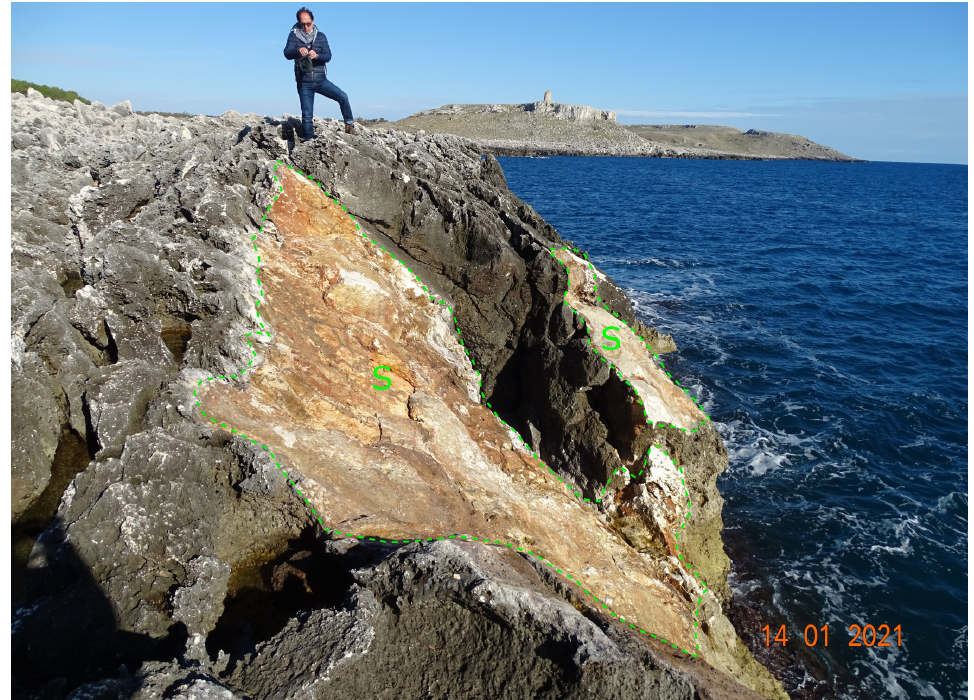
Figure A9. Torre Sant’Emiliano coast. The sockets of the boulders SEa and SEb are highlighted by the green dashed